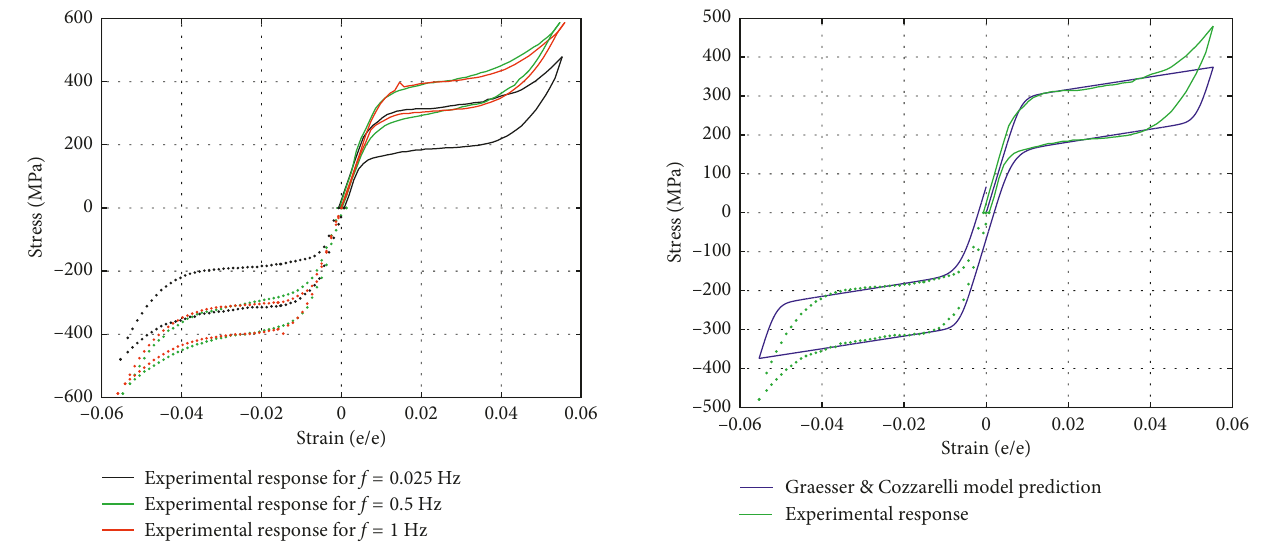
Figure 4: Comparison of the experimental responses at frequencies of 0.025, 0.5, and 1 Hz.